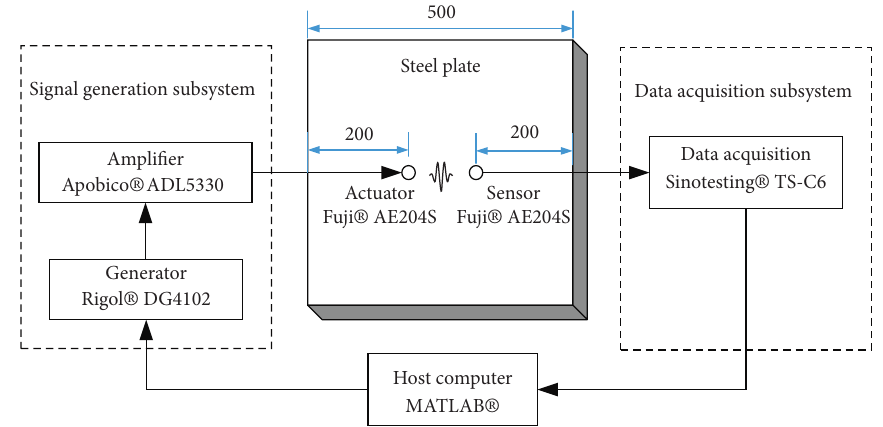
Figure 6: Sketch of the experiment setup with an actuator-sensor pair based on the Lamb wave.